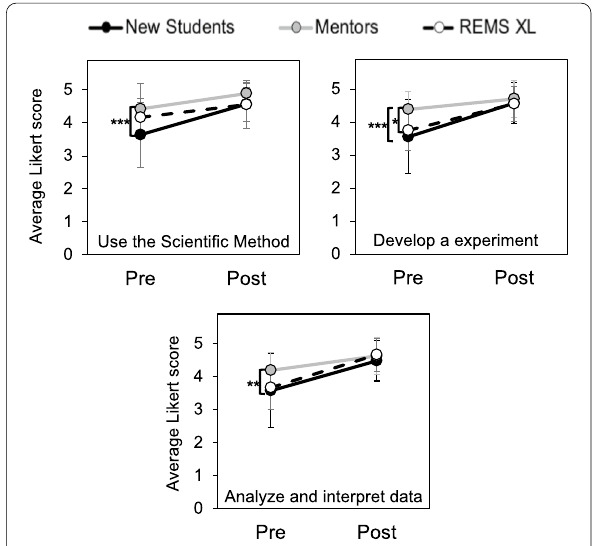
Fig. 13 Competence: Comparing science skills competence scores among student groups. Average Likert scores (1 great deal) on competence REMS survey items relating to three (3) science skills collected from new students (black circle, black line; N 87) and mentors (grey circle, grey line; N = students (white circle, dashed line; N among student groups were analyzed with Kruskal–Wallis tests with